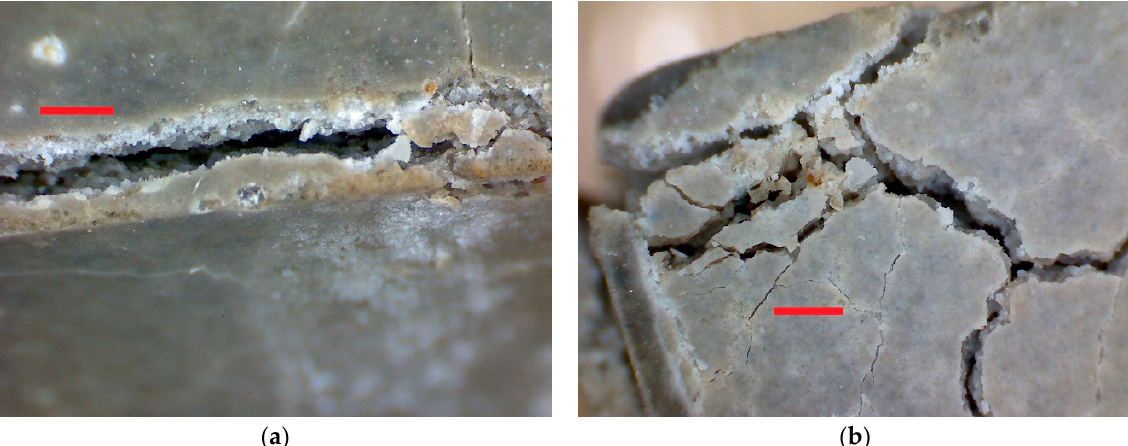
Figure 15. M6 after 420 days in the sulfate bath: ( a ) most specimen edges do not exhibit any signs of cracking; ( b ) first hairline cracks can be observed on one of the four specimens; the red line indicates a length of 1 mm.